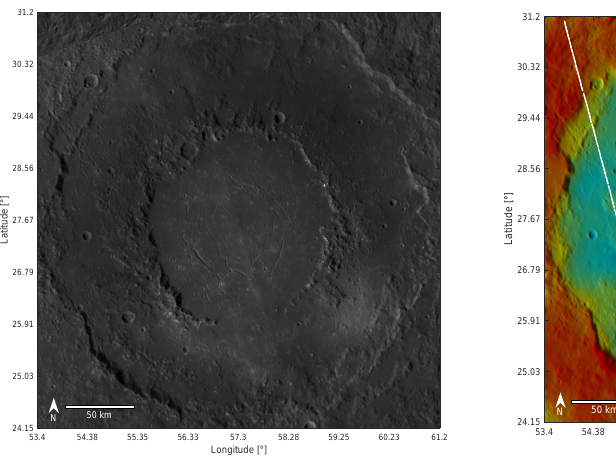
Figure 13. ( a ) Mosaic of WAC images of the Rachmaninoff basin at a resolution of 255m/pixel. ( b ) Color-coded representation of the SfS DTM. The MLA sampling points are shown in red. The tracks were always recorded from south to north. The elevations of the individual tracks are compared to the reconstructed surface from left to right in Figure 14.